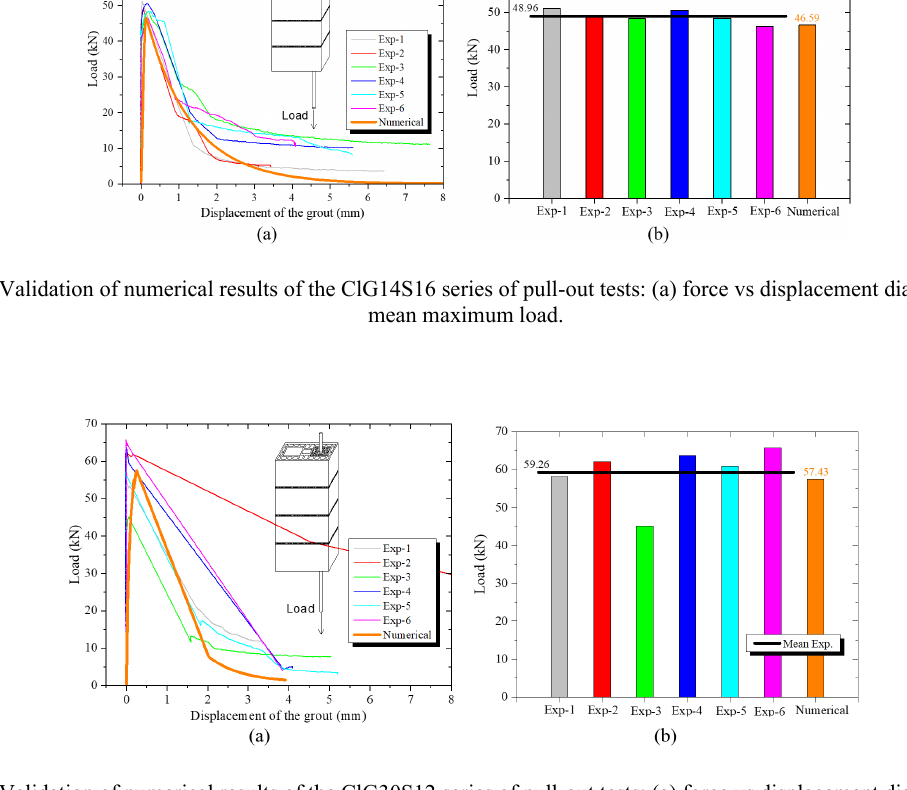
Figure 14. Validation of numerical results of the ClG30S12 series of pull-out tests: (a) force vs displacement diagrams and (b) mean maximum load.